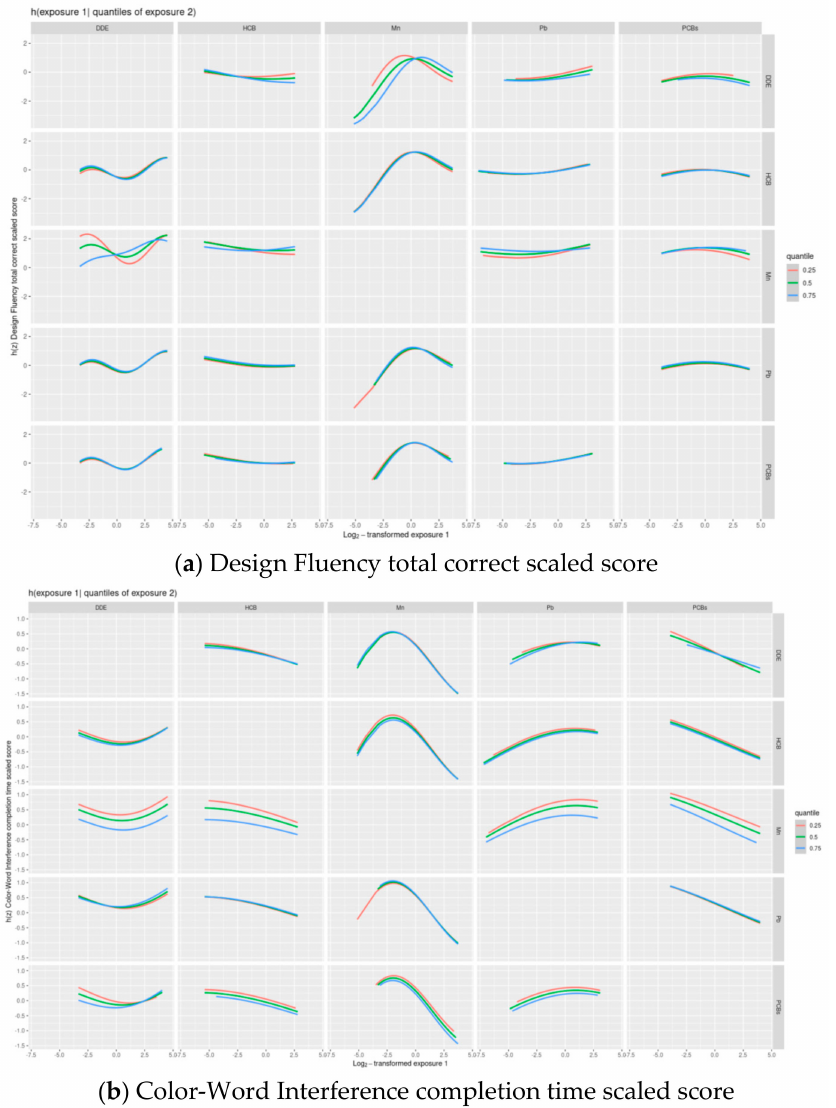
Figure 3. Exposure-response functions 1 associating each of the five main exposures (Set 1 2 ) and a second exposure fixed at various quantiles with the Delis–Kaplan Executive Function System inhibition scaled scores: ( a ) Design Fluency total correct scaled scores and ( b ) Color–Word Interference completion time scaled score, while the remaining exposures are assigned to their median value among adolescents in the main analysis group. 1 Exposures have been log2-transformed and models have been adjusted for child race, sex, age at exam, year of birth, and HOME score; maternal marital status at child’s birth, IQ, seafood consumption during pregnancy, and smoking during pregnancy; maternal and paternal education and annual household income at child’s birth; and study examiner. 2 Set 1: complete outcome, covariate and exposure data for DDE, HCB, Σ PCB 4 , Pb and Mn, n = 373.Abbreviations: DDE: dichlorodiphenyldichloroethylene; HCB: hexachlorobenzene; Σ PCB 4 : Sum of 4 PCB congeners (118, 138, 153, 180); Pb: lead; Mn: manganese. Therefore, the Design Fluency model